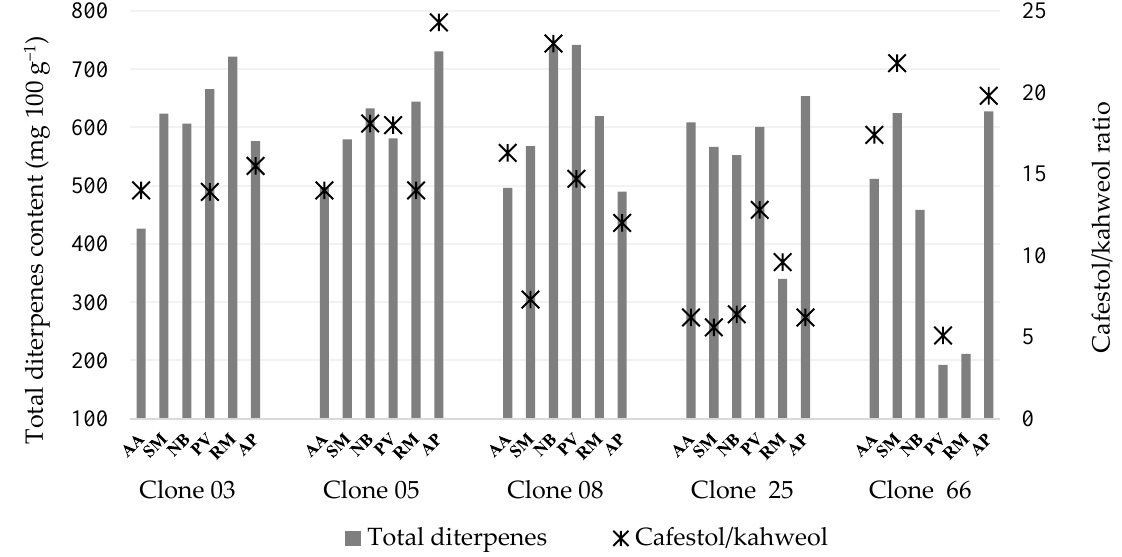
Figure 1. Total diterpene content (mg 100 g −1 ) and cafestol/kahweol ratio for roasted C. canephora intervarietal hybrids cultivated in different growing sites. (Growing site AA: Alto Alegre dos Parecis; SM: São Miguel do Guaporé; NB: Nova Brasilândia do Oeste; PV: Porto Velho; RM: Rolim de Moura; AP: Alto Paraíso. Table 2. Kahweol contents * (mg 100 g −1 ) for roasted C. canephora intervarietal hybrids cultivated in different growing sites.